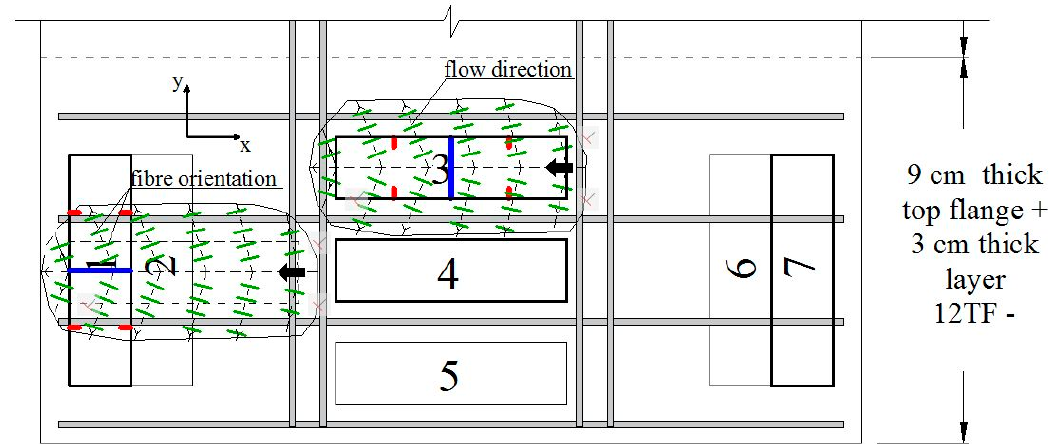
Figure 20. Fiber orientation in the top flanges of the R/SFRC box girder prototype.